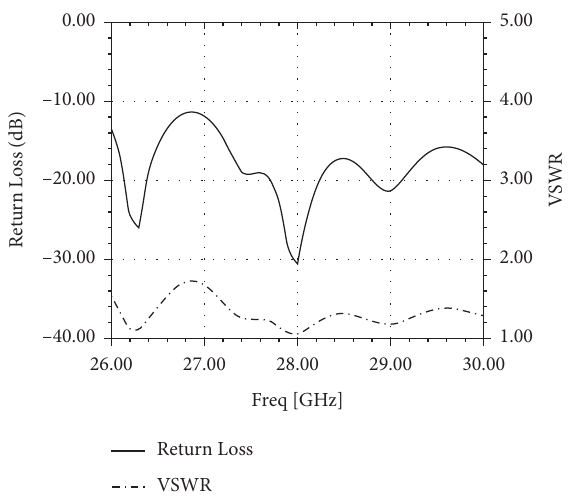
Figure 4: Designed 8 × 4 broadside uniform array antenna sim- ulation results of return loss (S11) and VSWR.